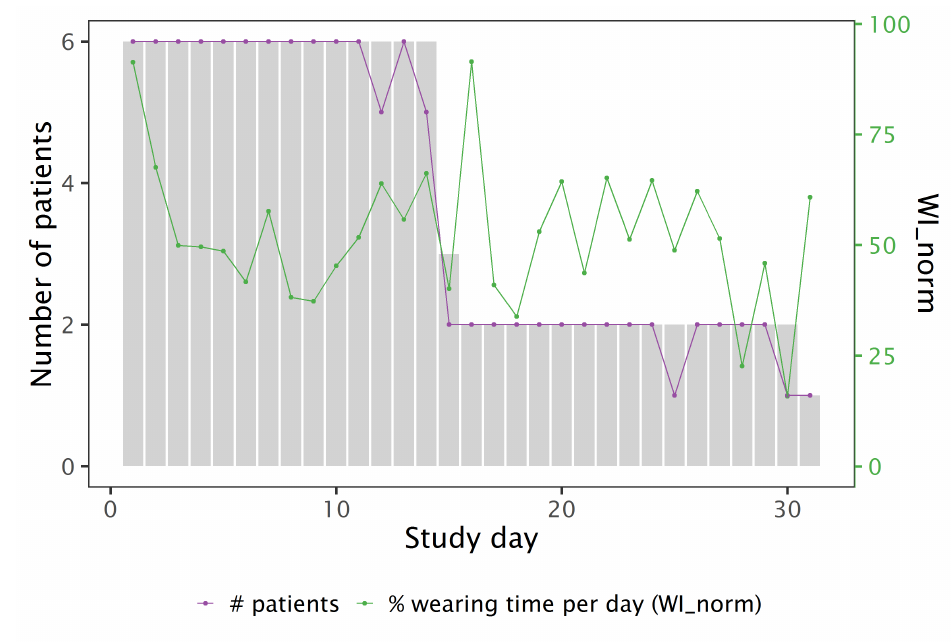
Figure 5. Average wearability index (normalised to a 16 h day) of the six included patients. The bars denote the number of participating patients, the violet line represents the number of patients that have worn the smartphone at a day and the green line denotes the average WI of these patients at a